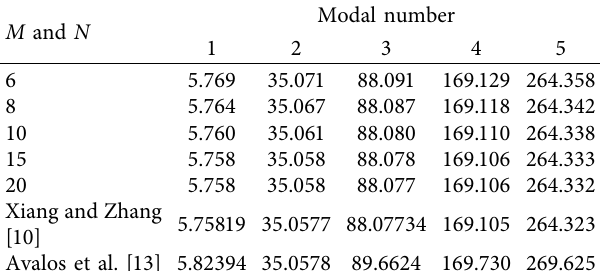
������ 􏽰 ρ h with M / D 2 2